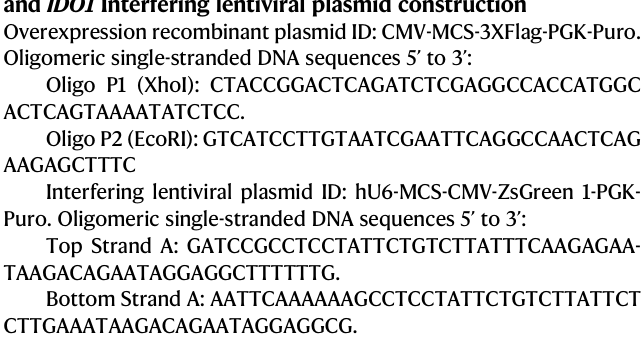
Fig.8|AntidistaltumoreffectandimmunologicalmemoryofLGG-MHS+USin the 4T1 bearing mice model. a Schematic diagram of the establishment of distal tumors model and the experimental procedure of treatment. b Average tumor growth curves of primarytumorindifferent groups( n =5 mice per group). c Mean growth curves and d corresponding growth curves of distant tumors in different groups ( n =5 mice per group). e Immuno fl uorescence images of helper T lym- phocytes (CD3 + CD4 + ) and proliferated cytotoxic T lymphocytes (CD3 + CD8 + ) in 4T1 tumor tissue slices of distal tumor. f Schematic diagram of the establishment and treatmentprocessofmousemodelsoflungmetastasis. g Typical fl owcytometricof the effector memory T cells (CD3 + CD8 + CD44 + CD62L − ) (Tem) and (CD3 + CD8 + CD44 + CD62L + ) (Tcm) in the spleen after 24h after the fi rst